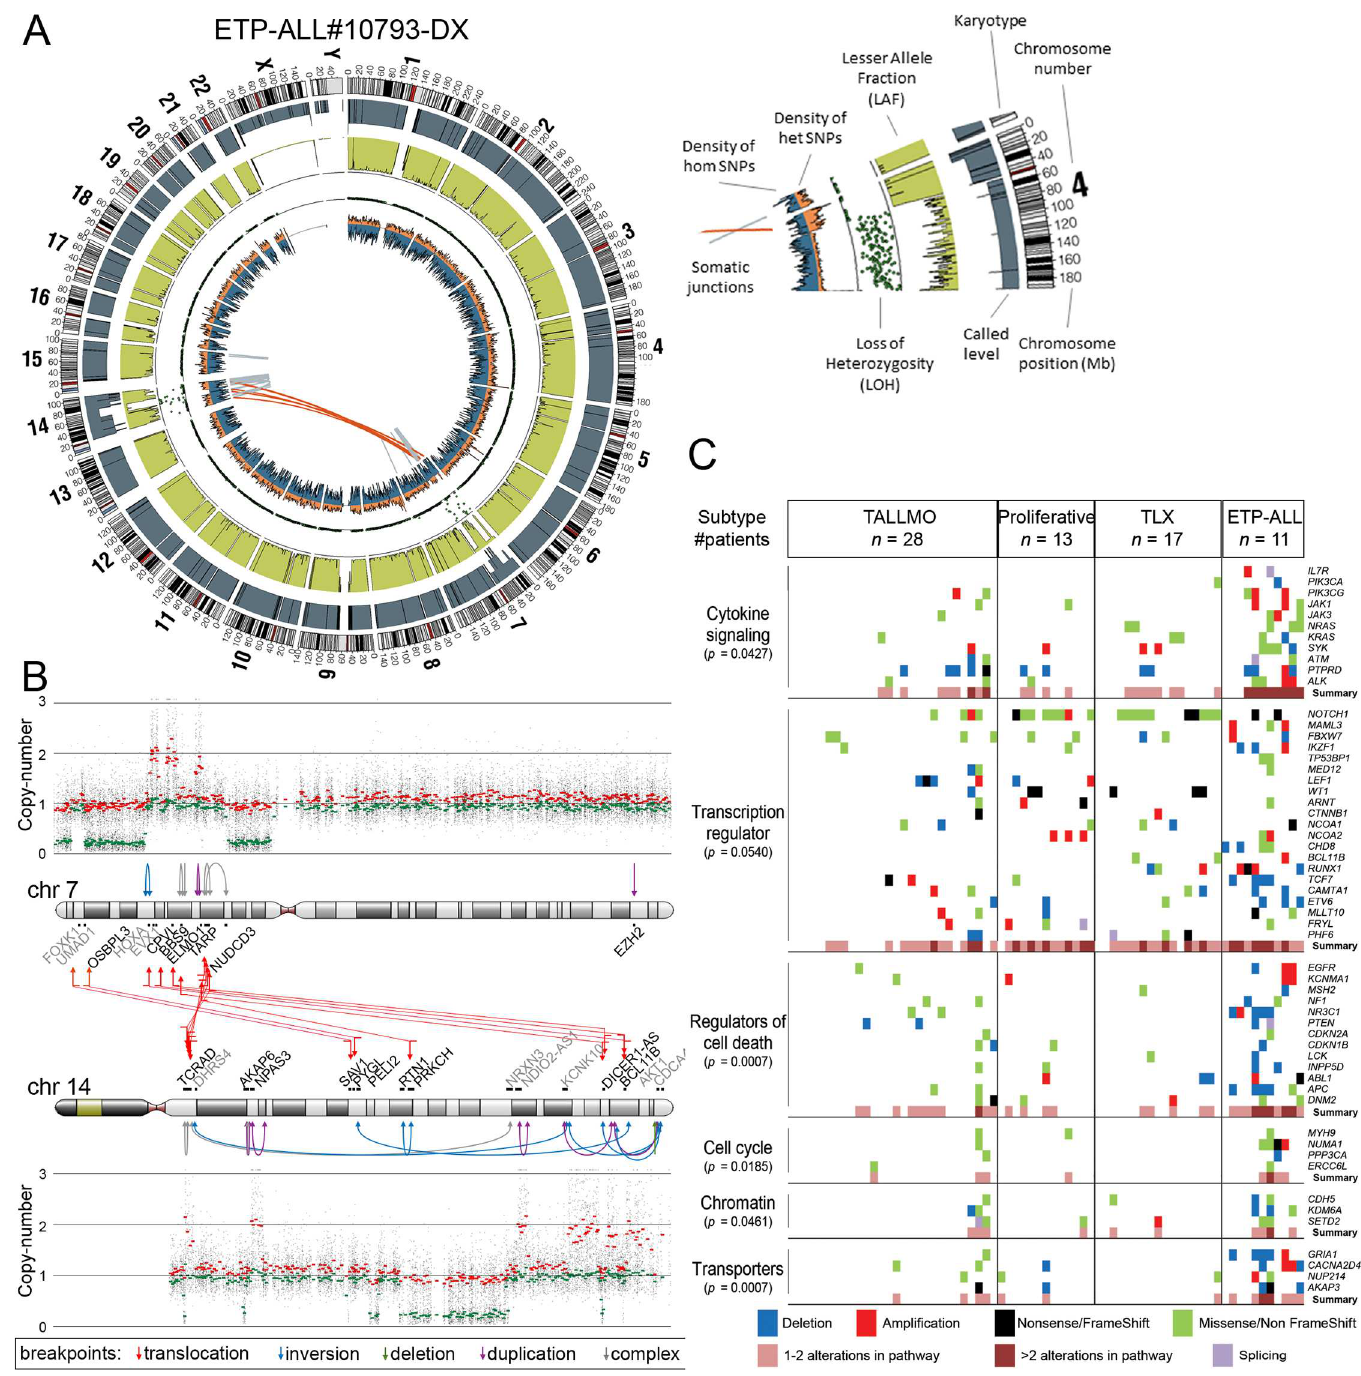
Fig 2. Whole genome and targeted exome sequencing results for pediatric T-ALL patients at diagnosis. (A and B) Visualizationof chromosomal breakpointjunctionsin diagnostic leukemiacells of ETP-ALL patient #10793.(A) Circos plot of somatic structural variationsas detected in the diagnostic sample (Dx) along with SNV densities(1-Mb window) and predicted LOH data as explainedin the accompanyinglegend.Interchromosomal junctionsare displayedas red lines, and intrachromosomal junctionsare displayedas grey lines. (B) Allele-specificcopy number variationsas determined by Affymetric SNP Array analysisand multipleWGS-predicted chromosomal breakpointsas a consequence of chromothripsis affecting Chromosomes 7 and 14 are displayed.In the copy number plots, black dots indicatethe unsmoothedallele-specific copy numbers. Red dots are the smoothedmaximal allele-specific copy numbers using a slidingwindowof 30 SNP probes, whilethe green dots reflect the smoothedminimalallele-specific copy numbers. Chromosomal breakpointjunctionsare displayedfor translocations (red arrows), inversions (blue arrows), deletions(green arrows), duplications(purplearrows), and complex rearrangements (grey arrows). Affected (in black) and flanking(in grey) genes for the interchromosomaltranslocations are indicated. (C) Overview